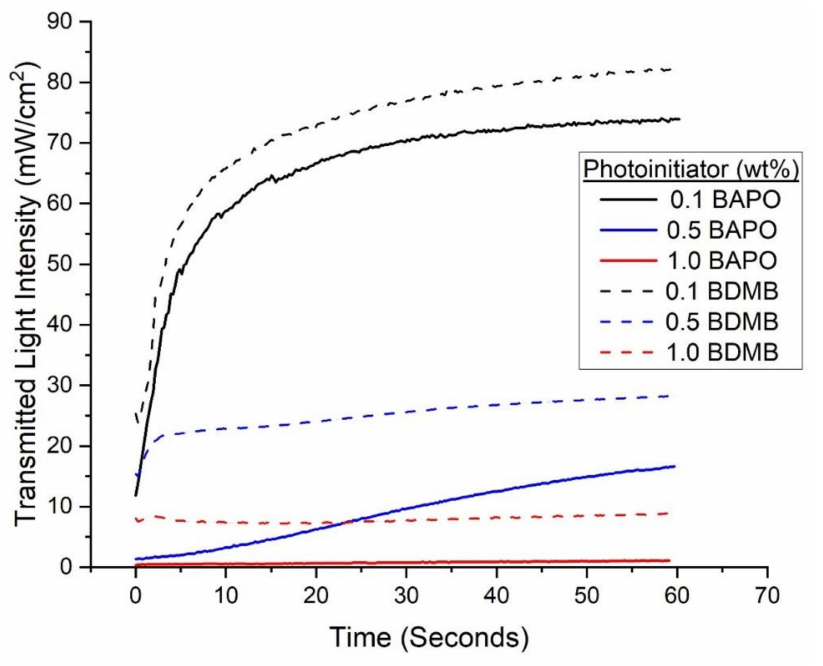
Figure 7. Experimental values for transmitted-light intensity at varying concentrations of PI for BAPO and BDMB through a 3-mm thickness of Bis-EMA/PETIA polymer.